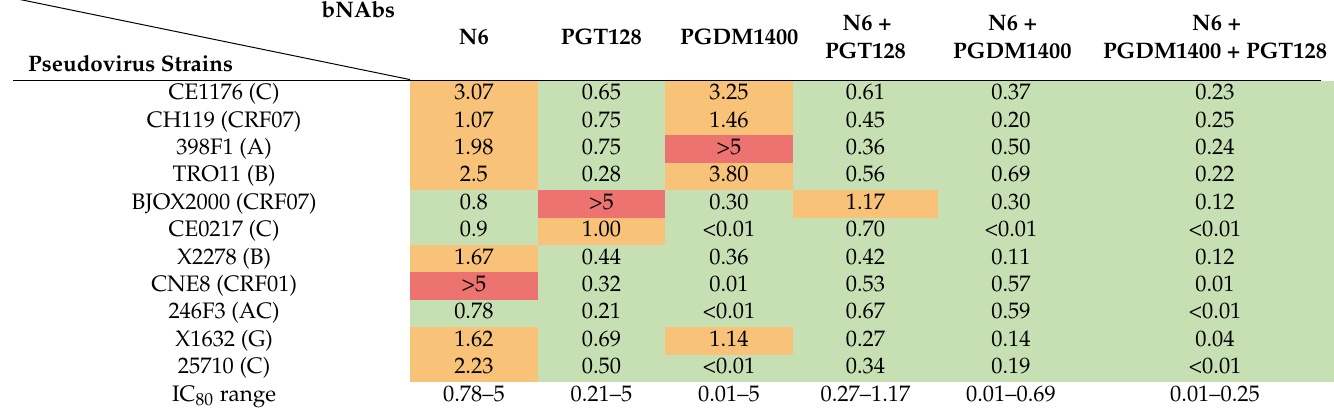
Table 5. IC 80 values for antibodies N6, PGT128, PGDM1400, and their combinations.